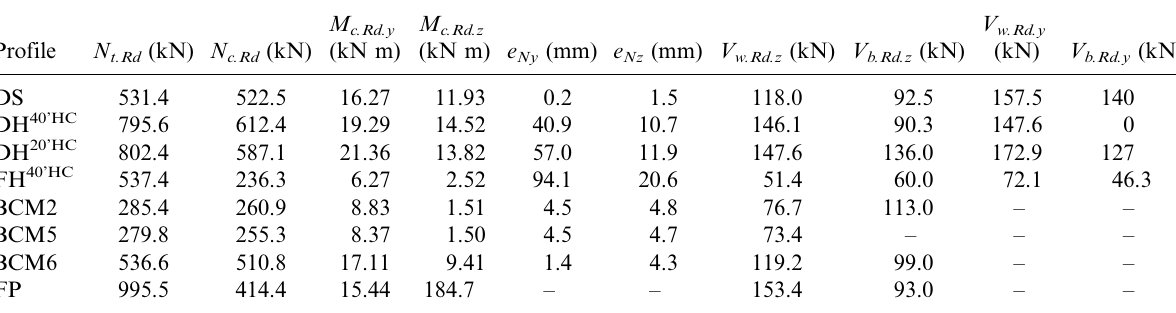
Table 12. Design strengths for profiles (effective sections)